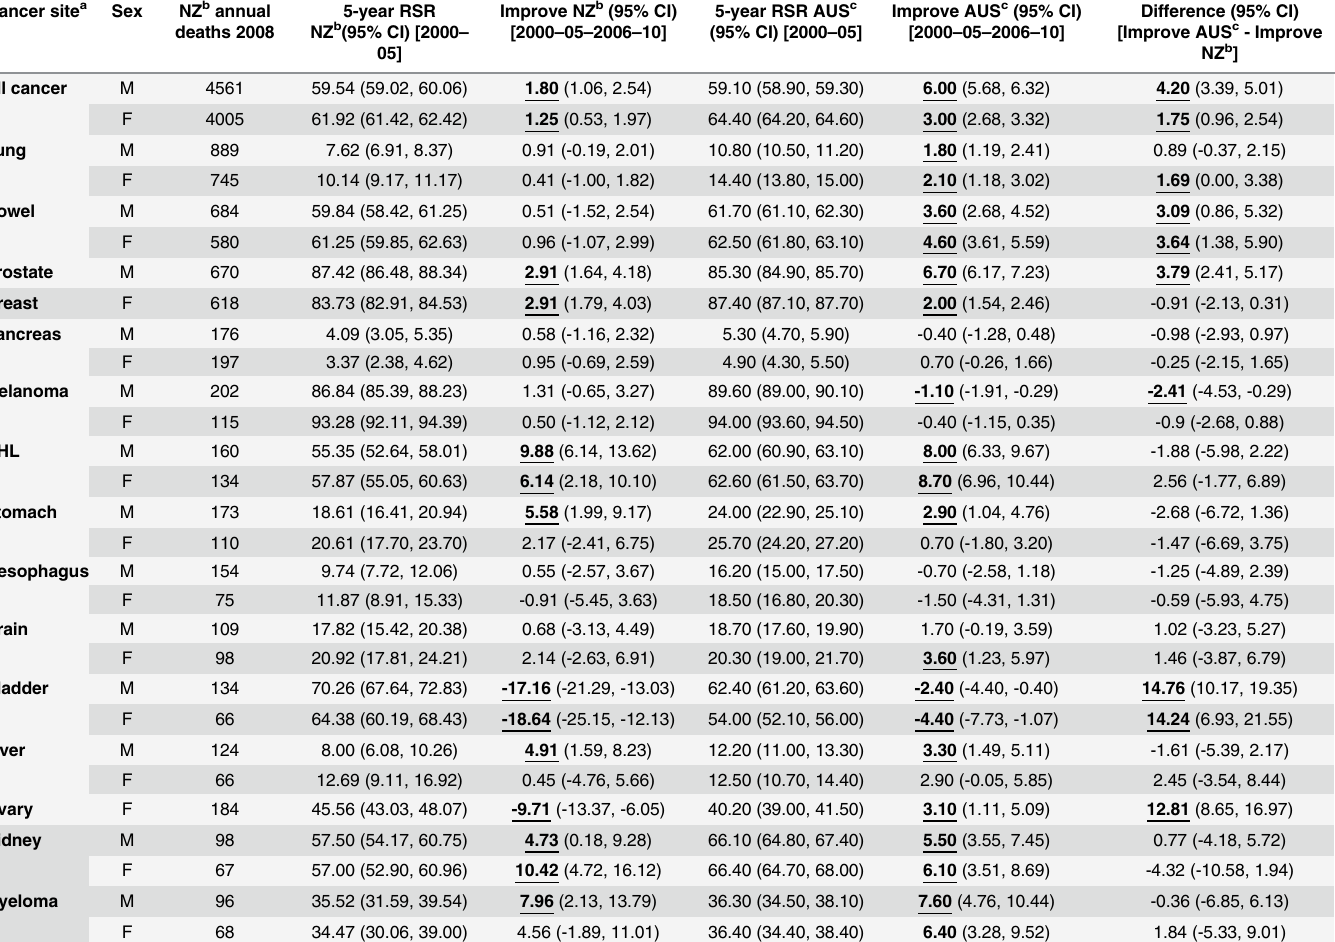
Table 1. Changes in cancer 5-year relative survival ratios over time (2000 – 05 and 2006 – 10) and comparison of changes in New Zealand and